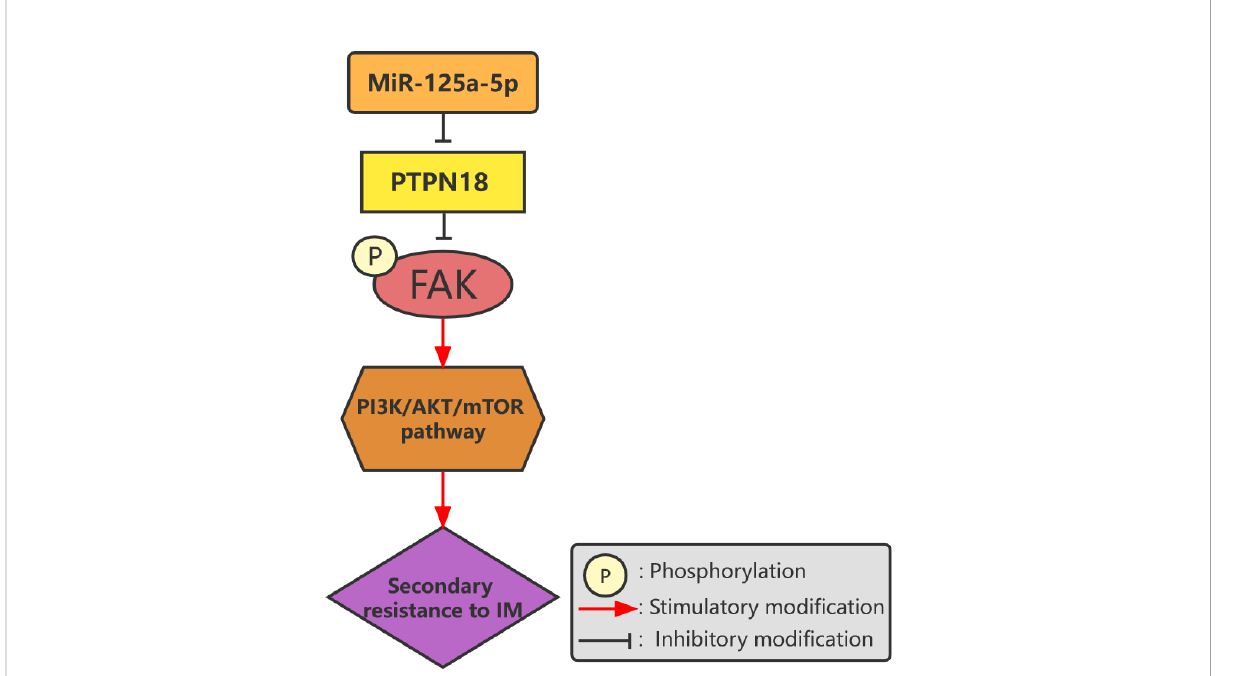
FIGURE 3 Overexpression of miR-125a-5p downregulates the expression of PTPN18 and promotes IM resistance in GISTs mediated by phosphorylated FAK